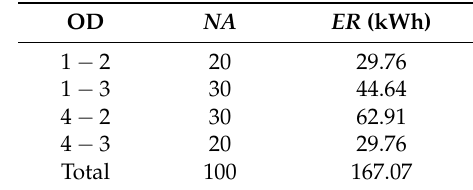
Table 6. OD Energy recharged.